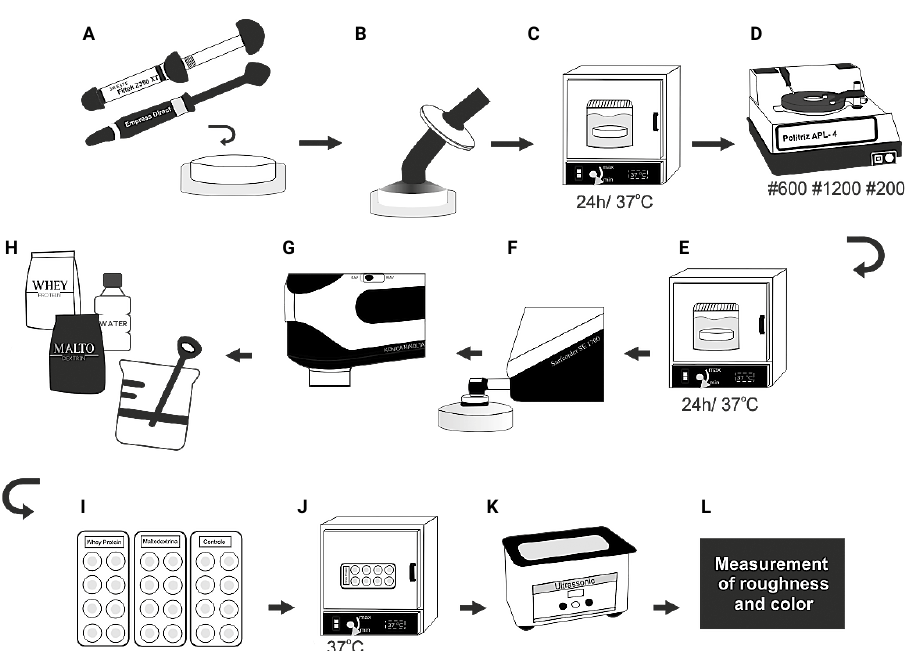
Figure 3. Flowchart representing the research steps: A - Insertion of composite resin in the matrix; B – Photoactivation; C – Storage of the specimens in deionized water for 24 hours in a 37˚C stove; D – Polishing with #600, #1200, and #2000 granulation files, followed by ultrasonic cleaning for 5 minutes; E – Storage of the specimens for additional 24 hours at 37˚C; F, G – Initial roughness and color measurements, respectively; H – Immersion protocol in solutions of deionized water, Maltodextrin, and Whey Protein; I – Specimens immersed in individual plastic compartments containing the solutions assessed; J – Storage in a 37˚C stove for 22.5 days for the control group and Maltodextrin, and 7.5 days for Whey Protein (to complete 22.5 days, the specimens were immersed in deionized water for 15 days); K – Cleaning of specimens in ultrasonic bath; L – Final roughness and color